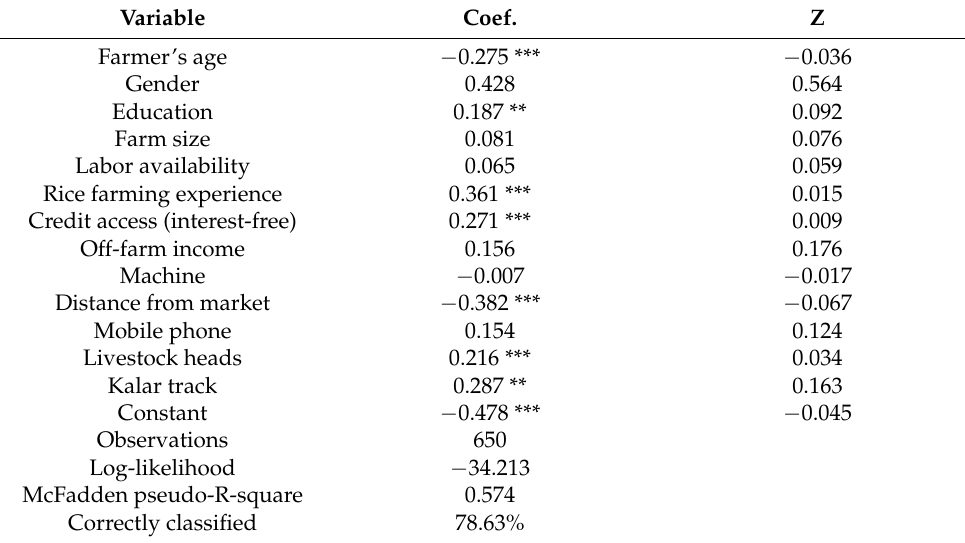
Table 6. Probit estimates of the contract farming